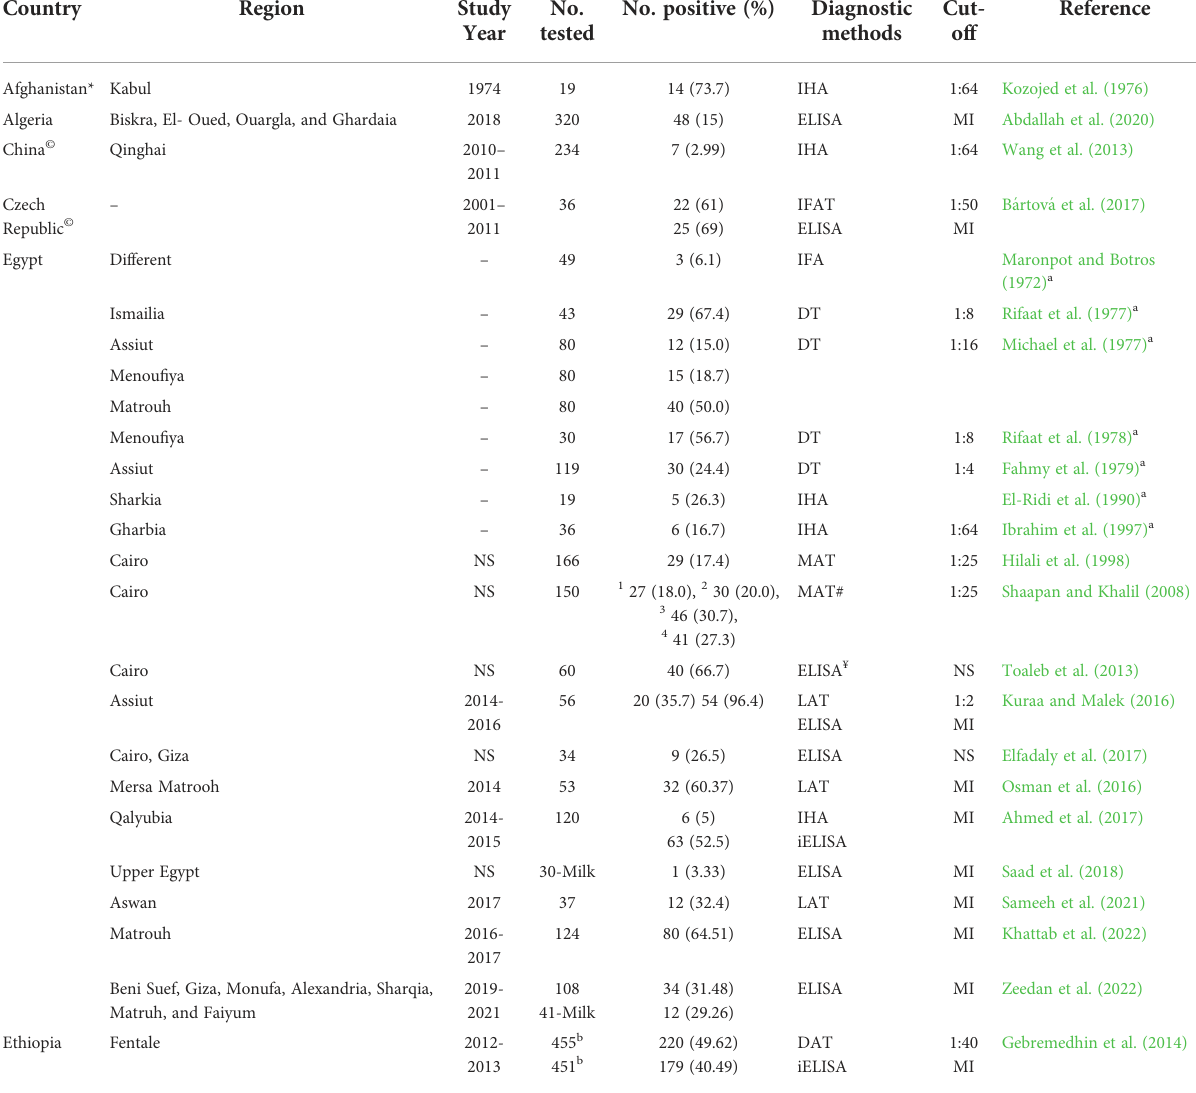
TABLE 4 Seroprevalence of anti- Toxoplasma gondii antibodies in camels ( Camelus dromedarius and Camelus bactrianus ) worldwide. Country Region Study